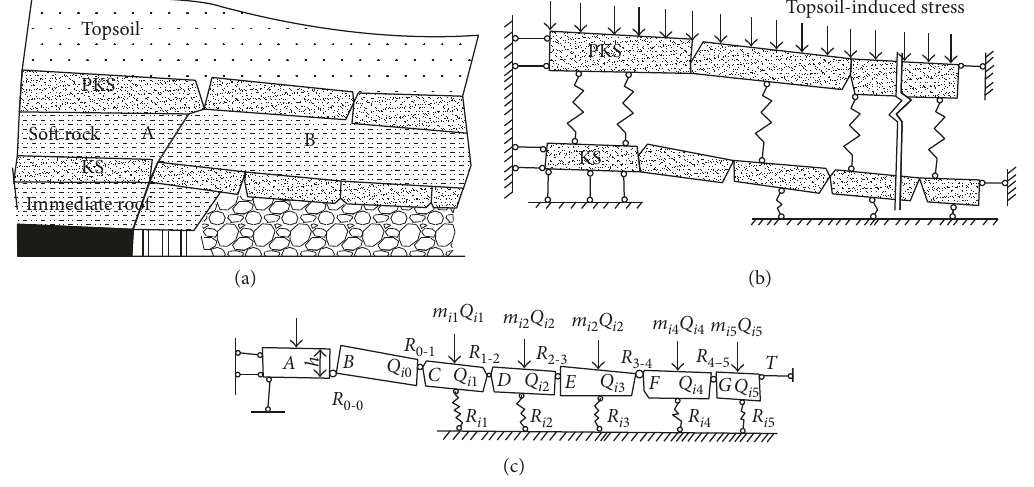
Figure 1: The mechanical model of the longwall overburden voussoir beam